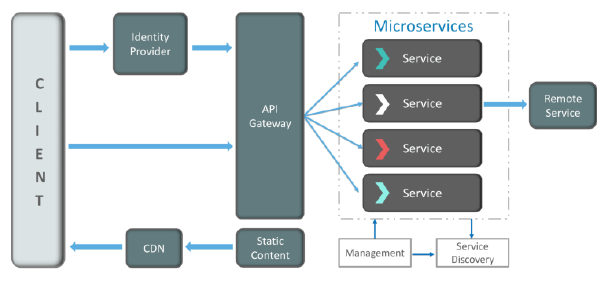
Figure 1. API-Gateway on Microservices